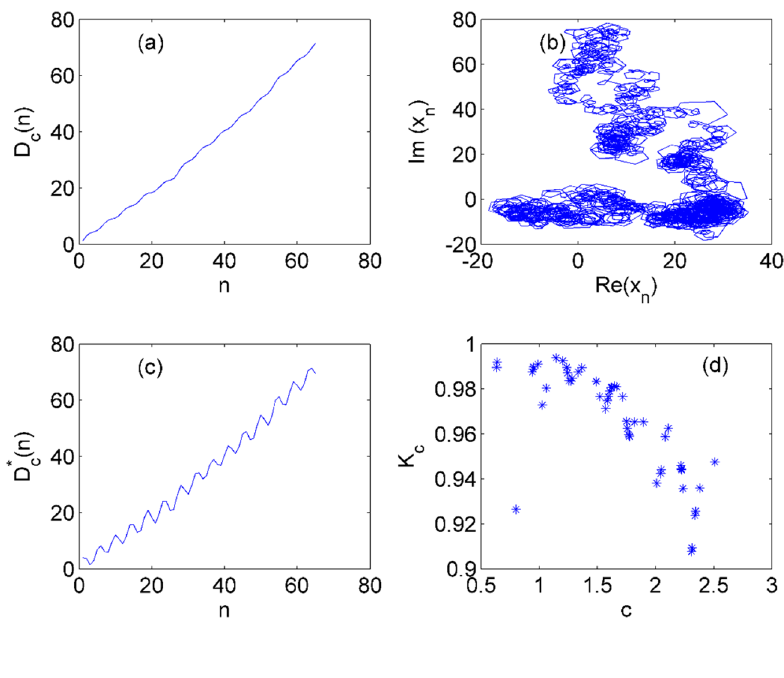
Fig. 4 a D c ( n ) versus n , b X n in the complex domain, c D ∗ versus n and d the asymptotic growth rate vs c for the Plan- etary K -index time series